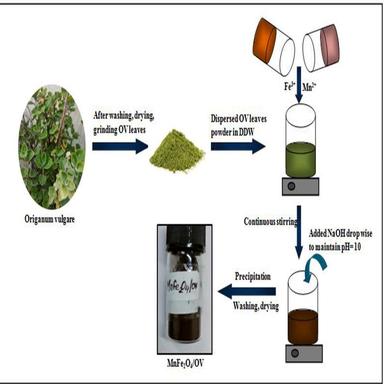
Step-wise representation of synthesis of MnFe2O4/OV via simple co-precipitation methods